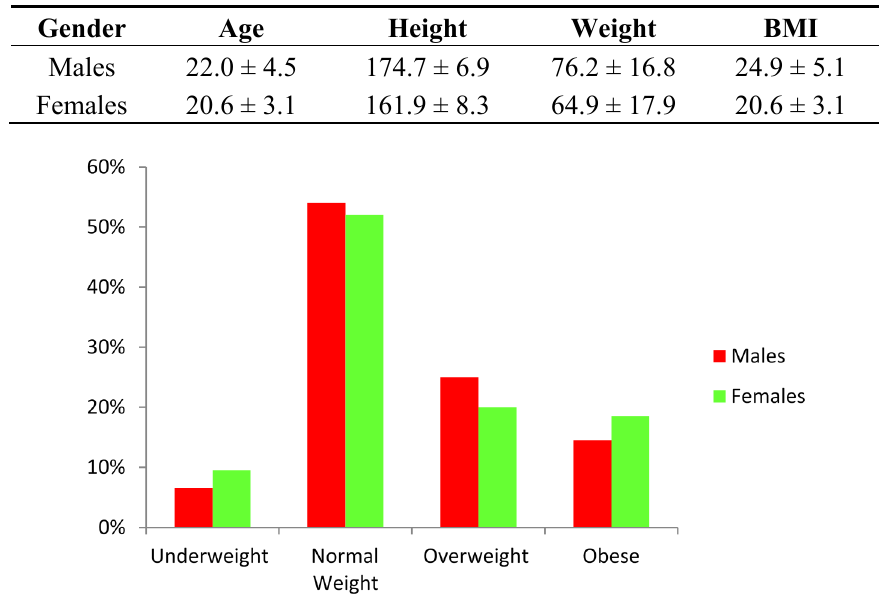
Table 1. Anthropometric characteristics (mean ± SD) of the overall sample.